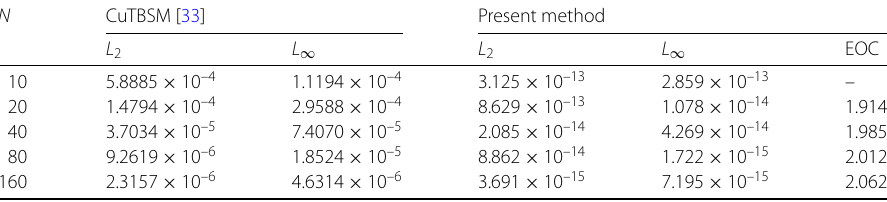
, α = 1.5 and 0 ≤ z ≤ 1 120